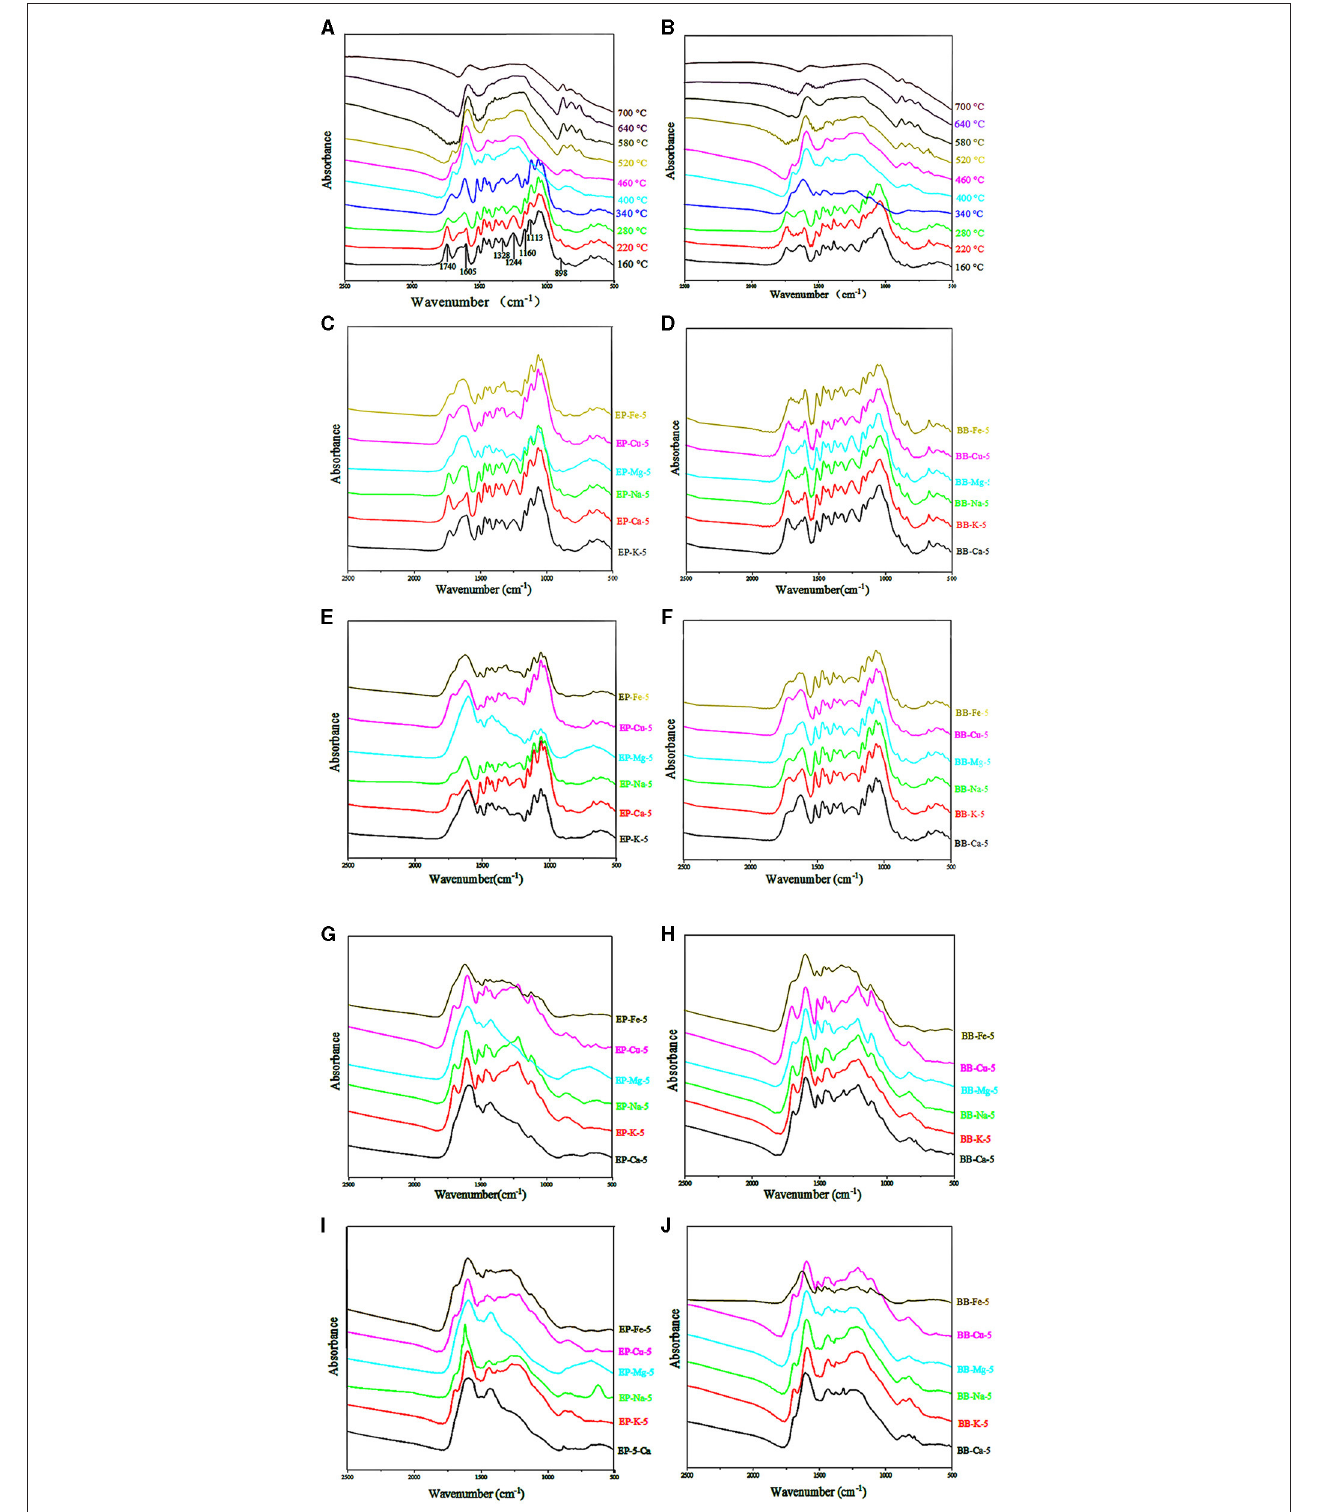
FIGURE 5 | Different samples FT-IR spectrums. (A) IR spectral of EP with different pyrolysis temperature. (B) IR spectral of BB with different pyrolysis temperature. (C) IR spectral of EP-5 which pyrolysis temperature was 220 ◦ C. (D) IR spectral of BB-5 which pyrolysis temperature was 220 ◦ C. (E) IR spectral of EP-5 which pyrolysis temperature was 280 ◦ C. (F) IR spectral of BB-5 which pyrolysis temperature was 280 ◦ C. (G) IR spectral of EP-5 which pyrolysis temperature was 340 ◦ C. (H) IR spectral of BB-5 which pyrolysis temperature was 340 ◦ C. (I) IR spectral of EP-5 which pyrolysis temperature was 400 ◦ C. (J) IR spectral of BB-5 which pyrolysis temperature was 400 ◦